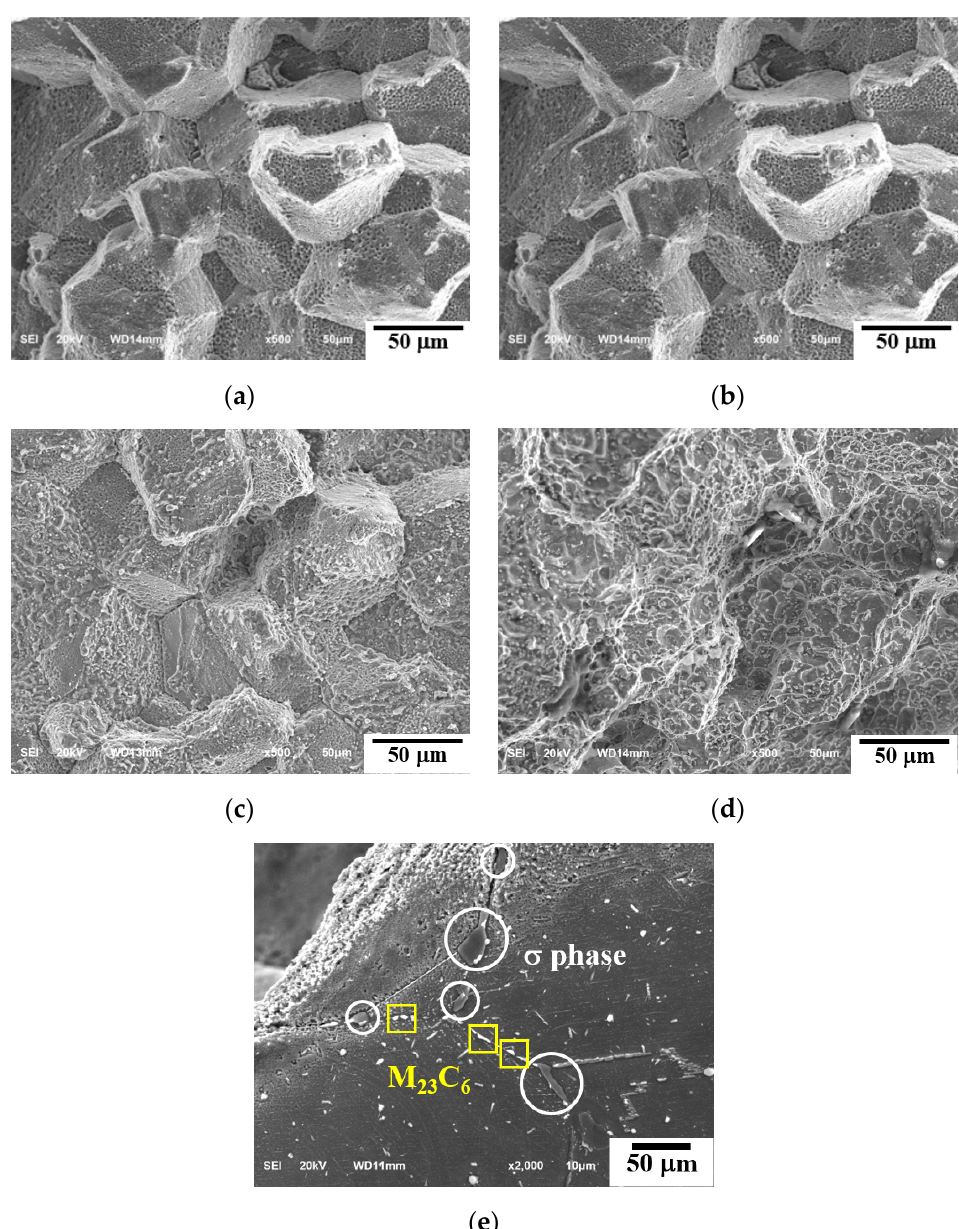
Figure 2. SEM micrographs of crept fractures: ( a ) 700 °C/180 MPa/398 h, ( b ) 700 °C/150 MPa/1463 h,